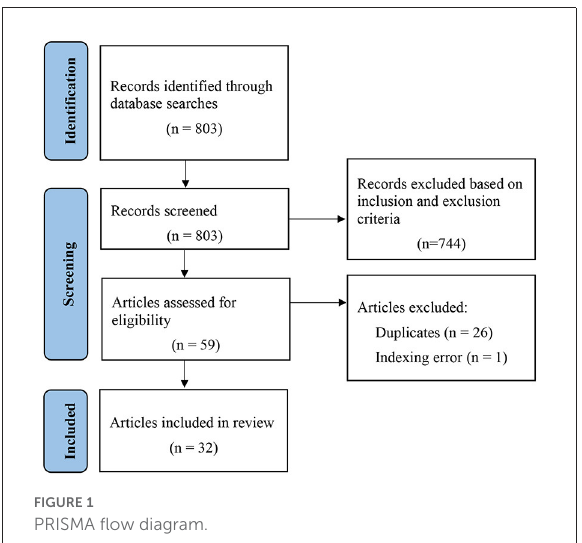
FIGURE1 PRISMA flow